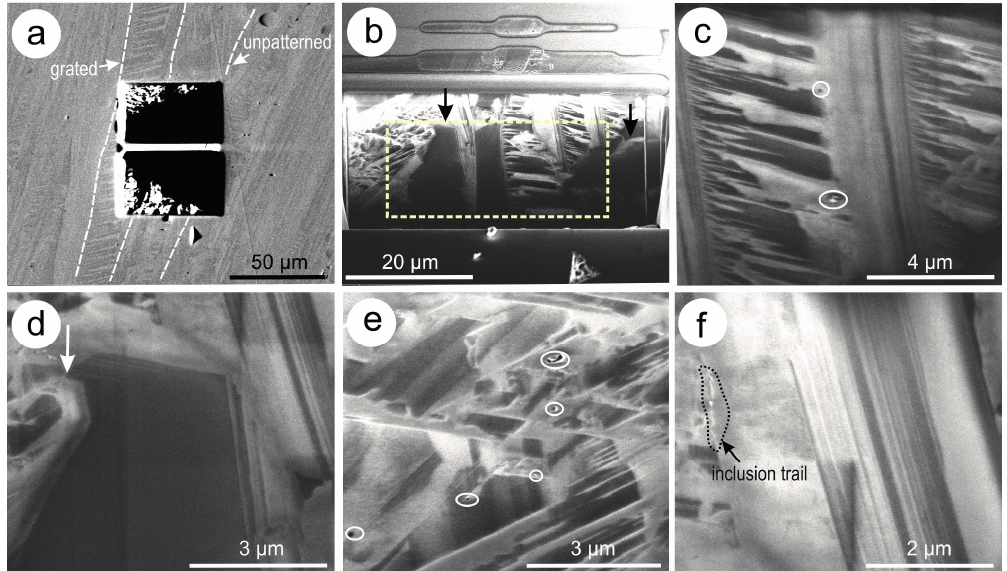
Figure 2. Secondary Electron (SE) images of (Ge-Fe)-rich areas showing: ( a ) location of FIB cut across the intricate sub-structure combining elongate blades and perpendicular subsets of short lamellae (marked); ( b ) extension of surface structures in depth exposed by FIB cross-sectioning in the middle part of the wall. Note presence of equant domains (arrowed) on the cross-section margins; the rectangle shows the area mapped in Figure 4; ( c ) detail of lamellar structures showing sub- μ m scale heterogeneity; pores ± inclusions are circled; ( d ) detail of a coarse grain with darkest appearance showing boundary relationships with brighter grain; note partial corrosion on one side (arrowed); ( e , f ) details of sub- μ m-scale heterogeneity expressed as fine banding in the brighter domains exposed in different orientations; pores ± inclusions are circled. FIB-SEM work performed on a Dual Beam FEI Helios Nanolab FIB-SEM platform at Adelaide Microscopy following methods outlined by [15].